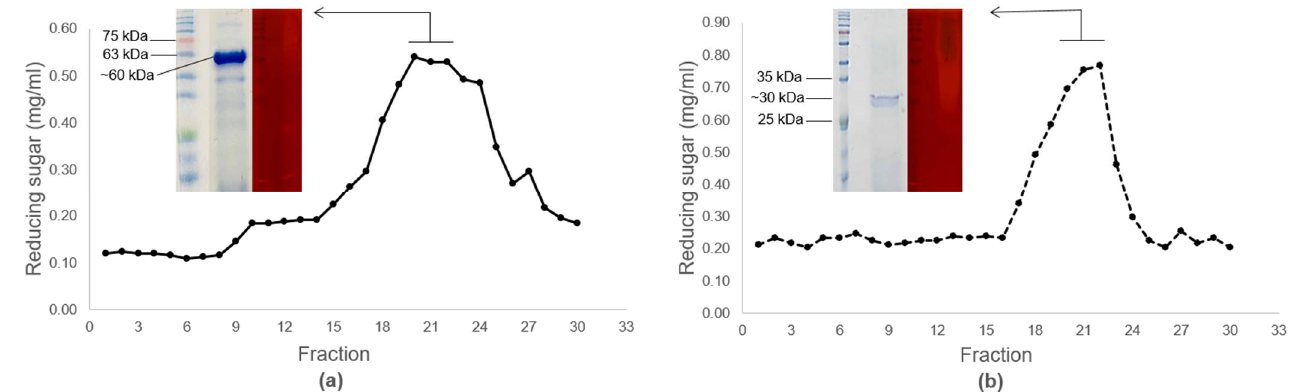
Figure 3. Evaluation of cellulase activities of ( a ) CBD2 and ( b ) CBD3, in the form of reducing sugars, in cellulase fractions obtained from size-exclusion liquid chromatography. The fractions with high cellulase activities were analyzed by SDS-PAGE analysis (blue color) and zymogram analysis (red color).